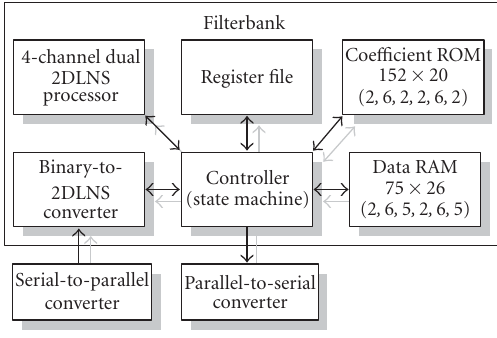
Figure 4: Filterbank